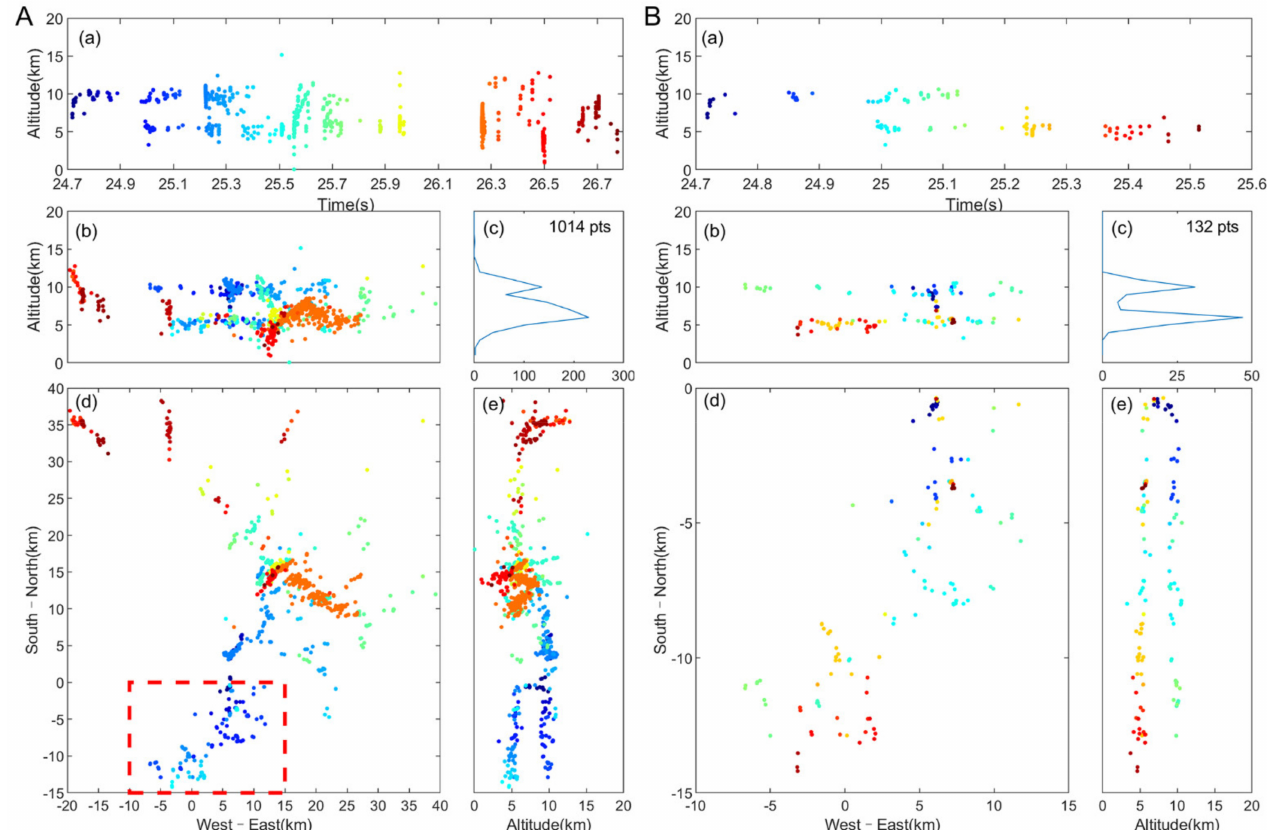
Figure 13. ( A ) The positioning results of the lightning process at 16:26 on 15 August 2015 under 5 dB SNR signals by the TOA–TR method and ( B ) the partial developments. In each subgraph, ( a ) height–time plots; ( b ) north–south vertical projection; ( c ) height distribution of radiation events; ( d ) plan view; and ( e ) east–west vertical projection of lightning radiation sources. Refer to Figure 11 of Chen et al. [46], the graph is redrawn based on the data from https: //zenodo.org/record/2644811#.YEB-PU7isdV (accessed on 4 March